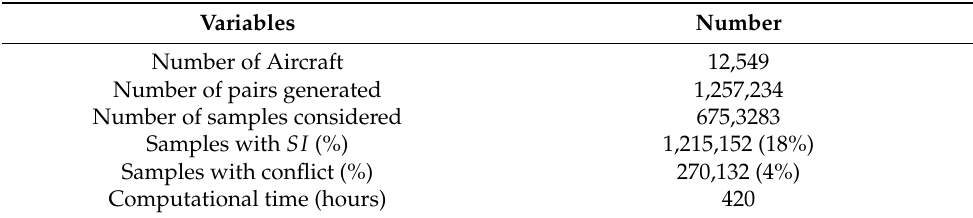
Table 1. Results of the simulations.